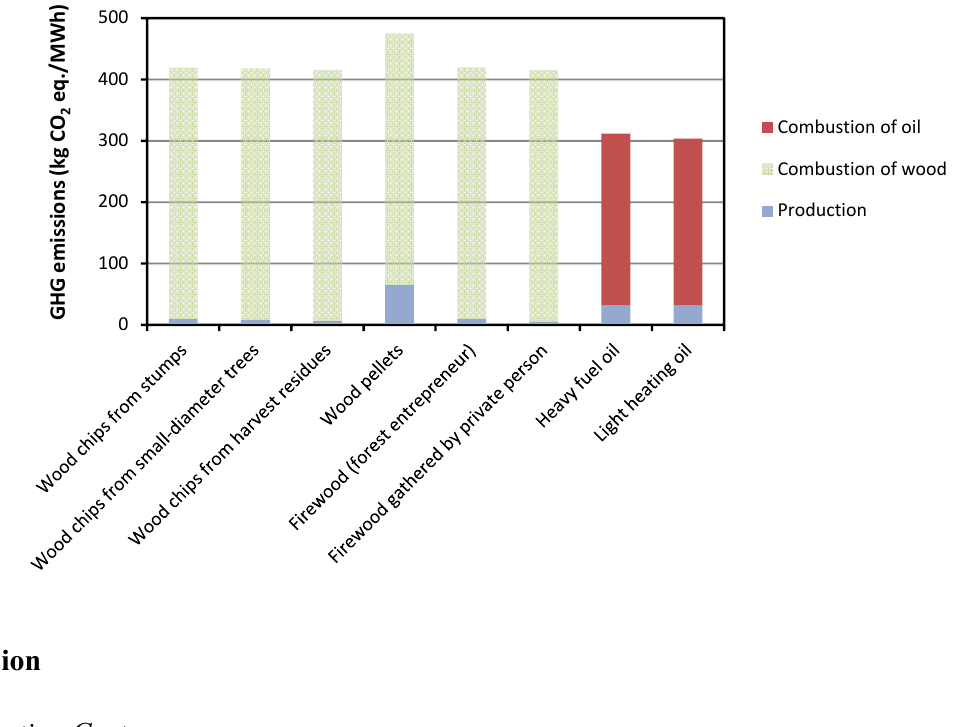
Figure 6. Greenhouse gas emissions (kg CO eq./MWh) from production and combustion of 2 wood chips, wood pellets, firewood and oil. Note: the stacked-bars highlighted in transparent green indicate combustion of renewable energy